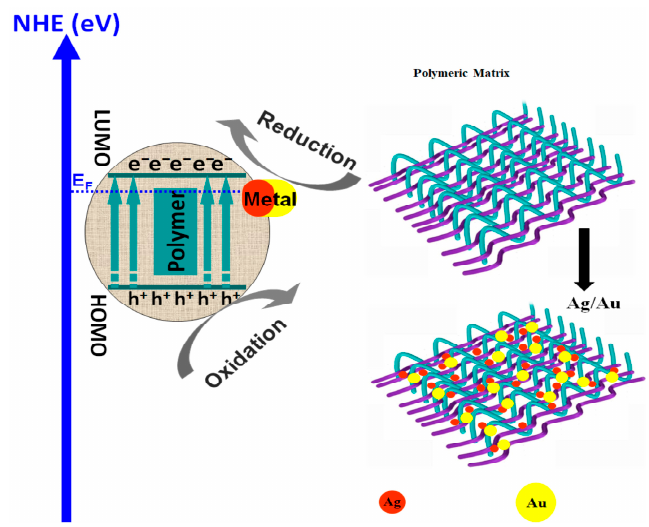
Figure 5. Polymer/metal composites for wastewater treatment.